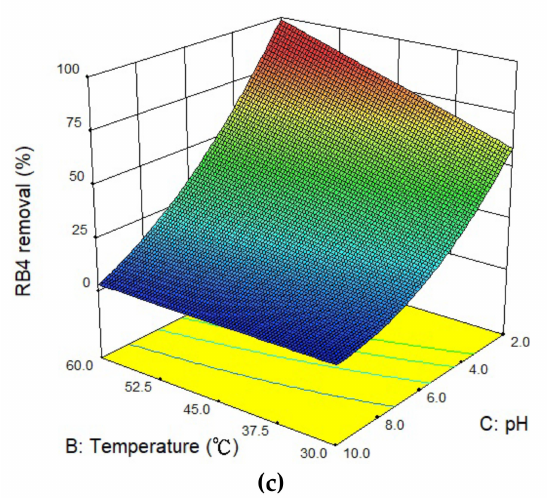
Figure 9. The 3D response surface plots of the removal rate of RB4 predicted by the response surface methodology (RSM) for ( a ) contact time and temperature, ( b ) contact time and pH, ( c ) pH and